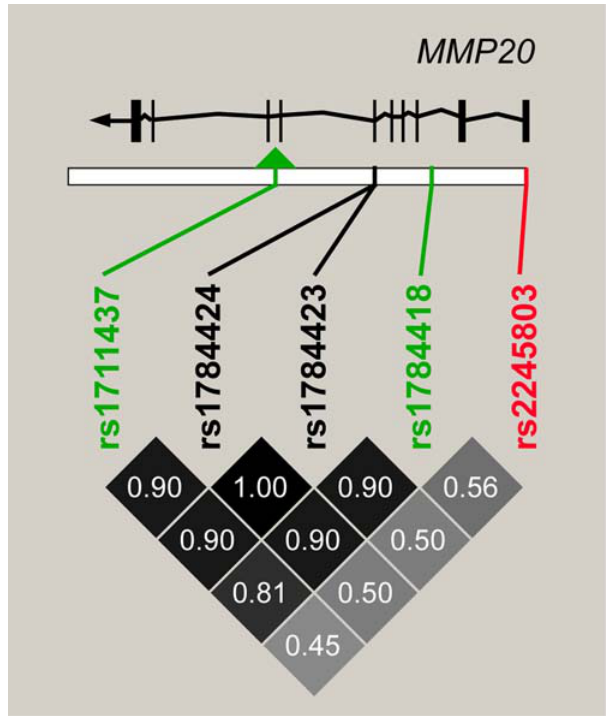
Figure 5. Linkage disequilibrium pattern of MMP20 . The two SNPs (green) for which we found significant associations with kidney aging are located in introns of MMP20 . They are linked to each other and to two nonsynonymous SNPs (black) located in exon 6 of MMP20 . Pairwise r 2 LD values (darker boxes correspond to higher r 2 values) from the HapMap CEU population are displayed. These four SNPs are not linked to the SNP (red) in exon 1 that associated with expression level of the